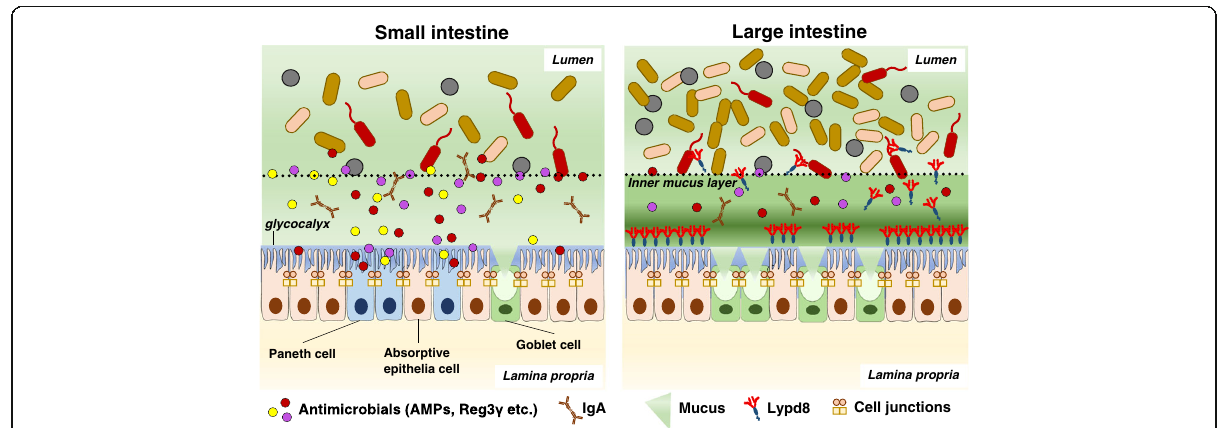
Fig. 1 Mucosal barriers in the gut. Chemical barriers including AMPs and Reg3 γ secreted by Paneth cells mainly contribute to the separation between intestinal bacteria and IECs in the small intestine. By contrast, in the large intestine where a tremendous number of bacteria exist, intestinal bacteria and IECs are largely segregated by physical barriers such as the inner mucus layer composed of polymerized MUC2 mucin. Lypd8, a highly glycosylated GPI-anchored protein expressed on IECs, inhibits the bacterial invasion of the inner mucus layer by binding to intestinal bacteria, especially flagellated bacteria. AMP: antimicrobial